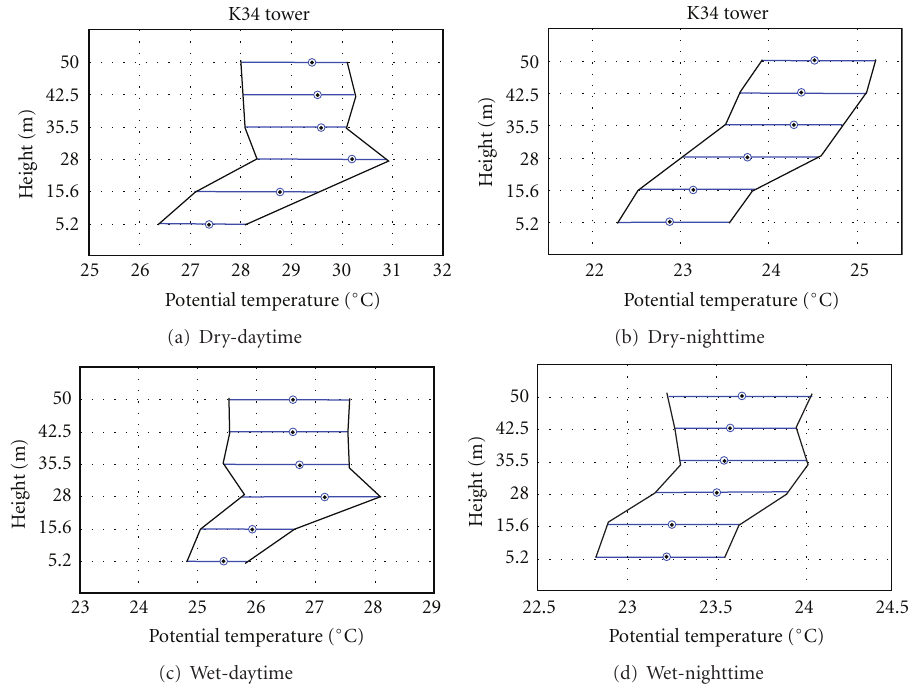
Figure 6: Boxplot of the virtual potential temperature vertical profile for dry ((a), (b)) and wet periods ((c), (d)) of the 2006 during night ((b), (d)) and daytime ((a), (c)), on the plateau K34